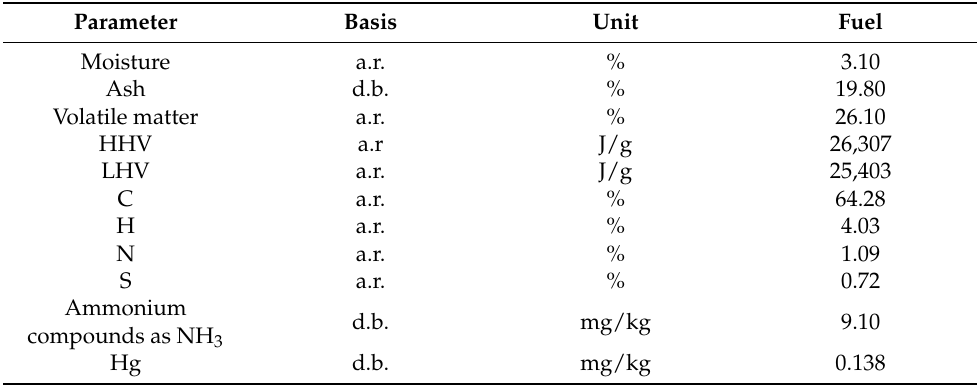
Table 1. Proximate and elemental analysis of fuel.